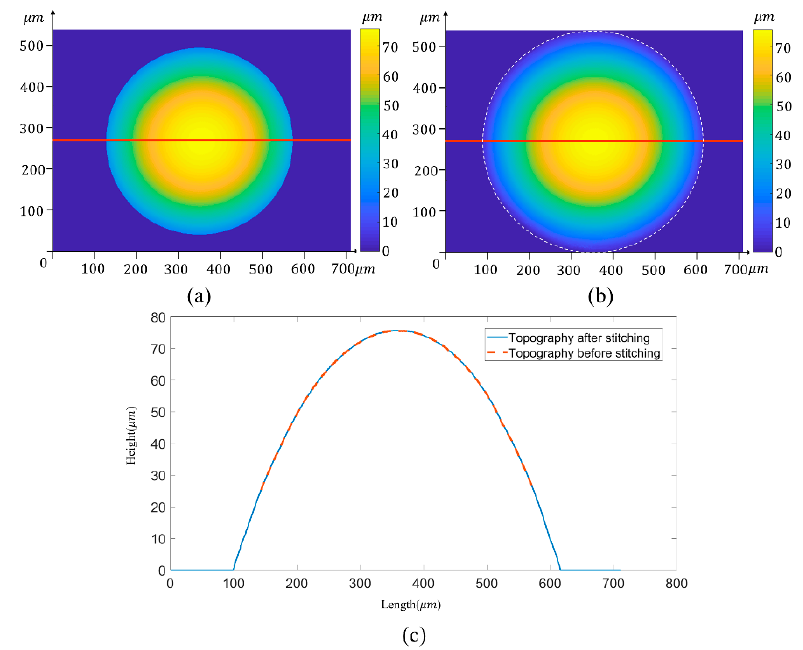
Figure 10. Recovered large gradient convex microlens ( a ) 3D topography for the conventional DHM system. ( b ) 3D topography for the multi-angle stitching DHM system. ( c ) Profile along the red line of topography before stitching and after stitching.